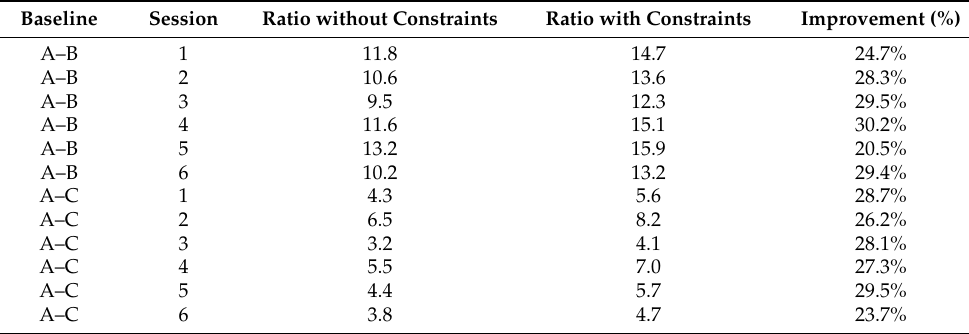
Figure 12. Ratio time series of baseline A–B ( a ) and A–C ( b ) with and without the static level constraints. Table 3. Ratio statistics with and without static level observation constraints.